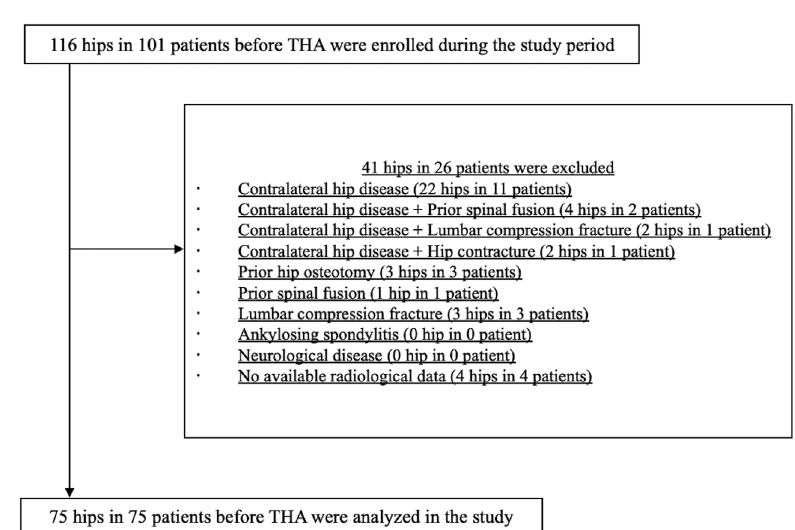
Figure 1. Study fl ow